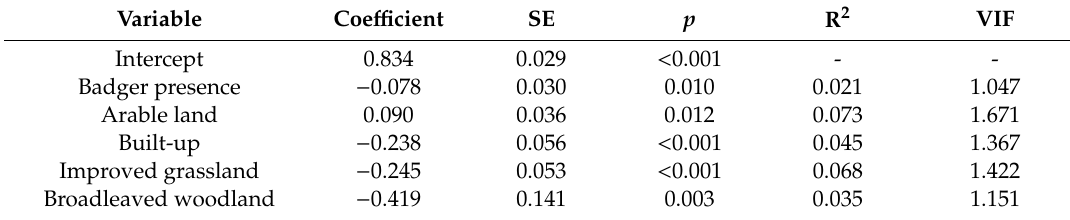
Table 2. Model results of generalised linear modelling (GLM) explaining the likelihood of the presence of hedgehogs. Significant variables were determined using backwards stepwise selection. SE = standard error and p = p -value. The independent contribution of each variable towards the explained variation (R 2 ; total = 0.242) was measured using hierarchical partitioning and VIF is the variance inflation